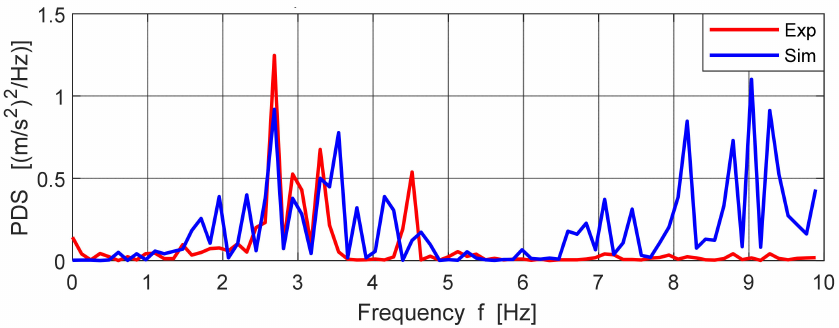
Figure 39. PSD of vertical accelerations on vehicle RA, 0–10